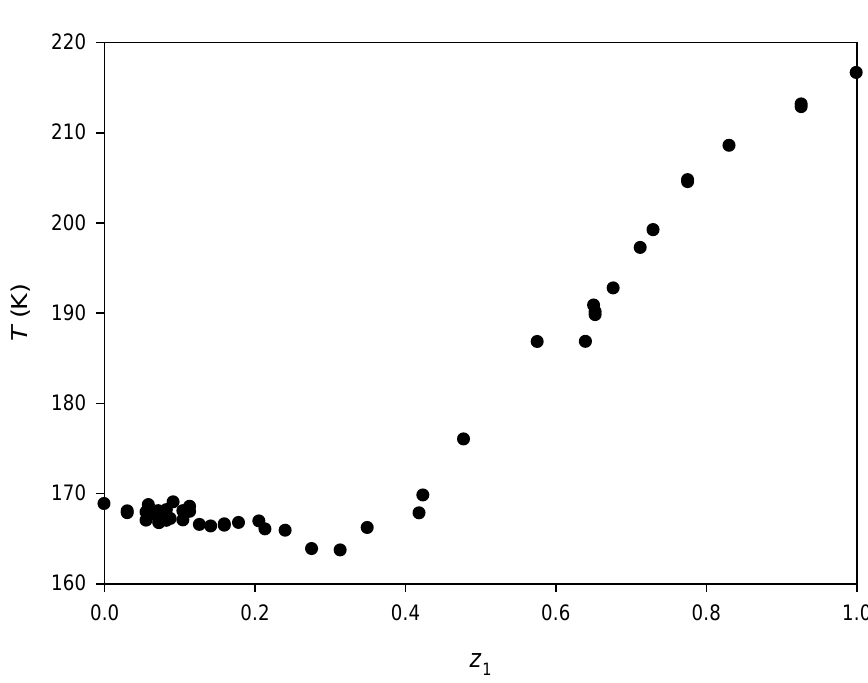
Figure 6. SLE for the R744 (1) + R1234ze(E) (2) binary pair.